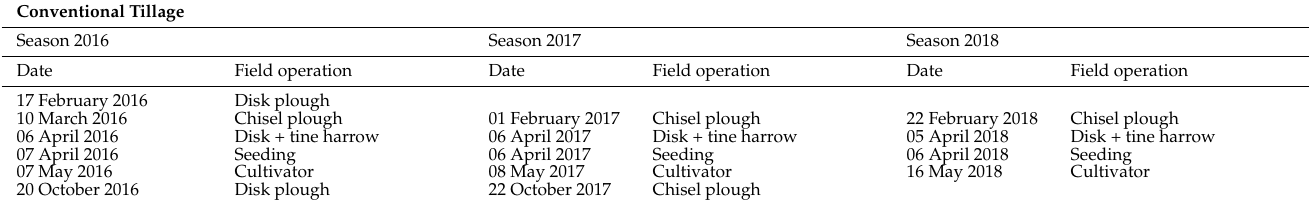
Table 1. The field operations performed each season per soil management